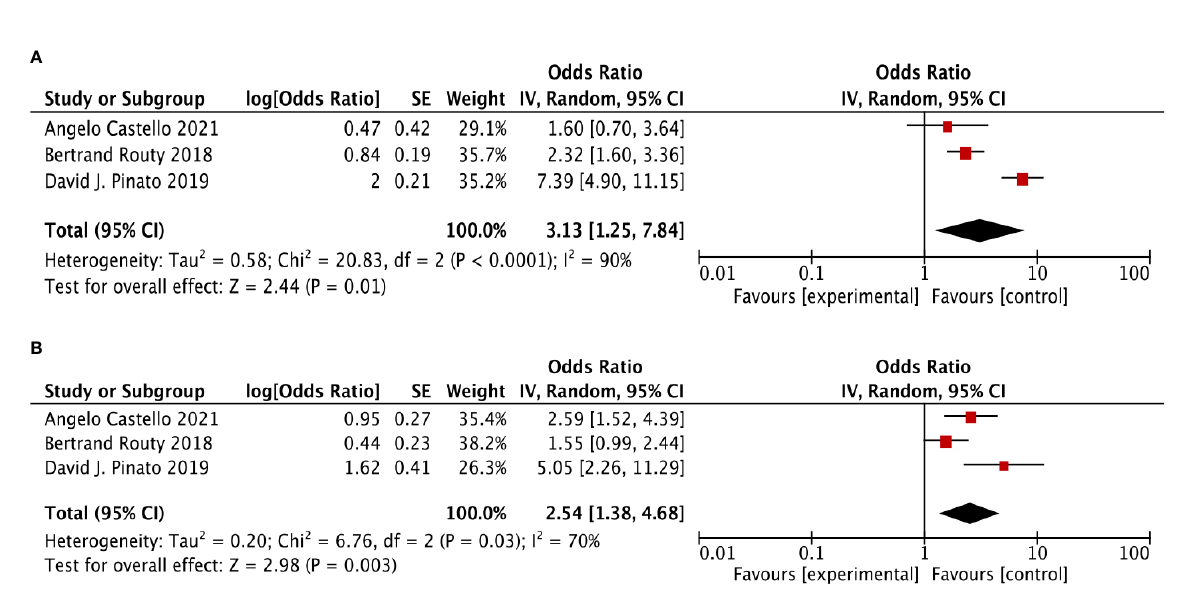
FIGURE 3 The forest plot showing the relationship between ATB use and OS, PFS in cancer patients treated with ICIs, based on randomized controlled trial (RCT). Overall survival (OS), progress-free survival (PFS); CI, con fi dential interval; Random, random-effects model. The random-effects model was adopted. (A) Overall survival (OS). (B) progress-free survival